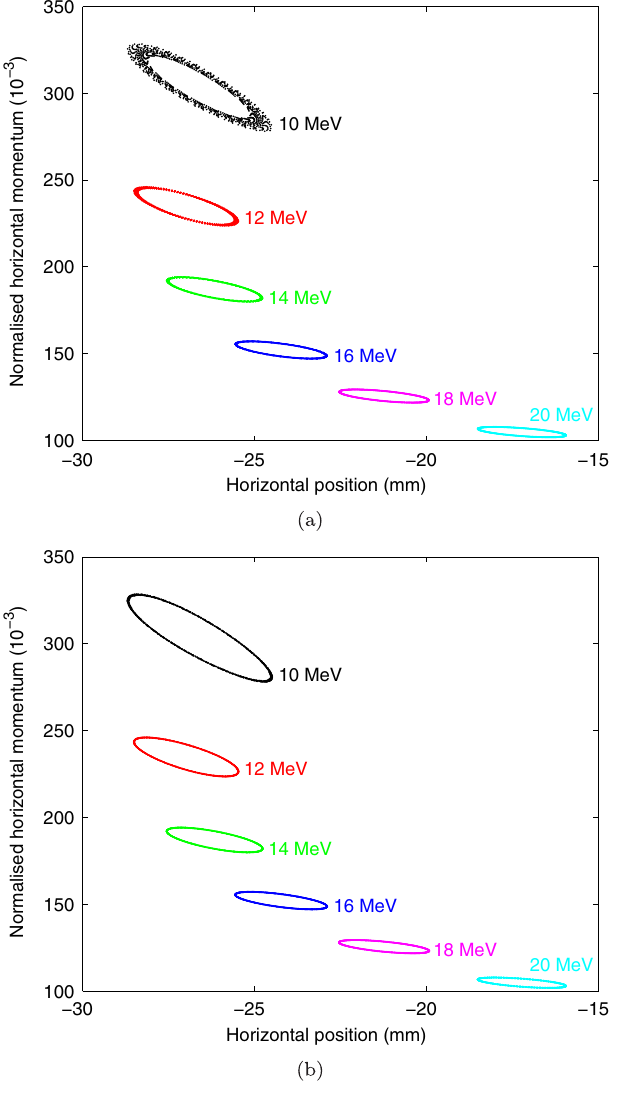
FIG. 5. Betatron motion at different reference energies with transfer maps (a) of order 2, and (b) of order 3. A different map was computed for each reference energy. For the maps of order 2, there issomenonphysicalgrowthintheamplitudeovertimefor10 and 12 MeV: this is a consequence of the loss of symplecticity arising from truncation of the map. The effect becomes signifi- cantly less visible if terms up to 3rd order are